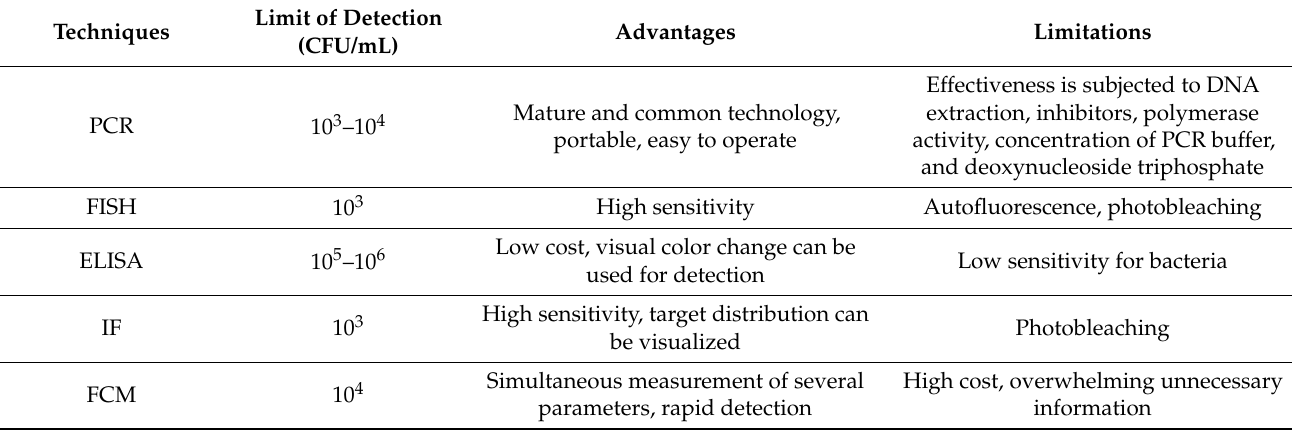
Table 1. Comparison of main techniques for the detection of plant diseases and their characteristics. PCR: polymerase chain reaction; FISH: fluorescence in-situ hybridization; ELISA: enzyme-linked immunosorbent assay; IF: immunofluorescence; FCM: flow cytometry; CFU: colony forming unit (adapted from [34]—licensed under the Creative Commons